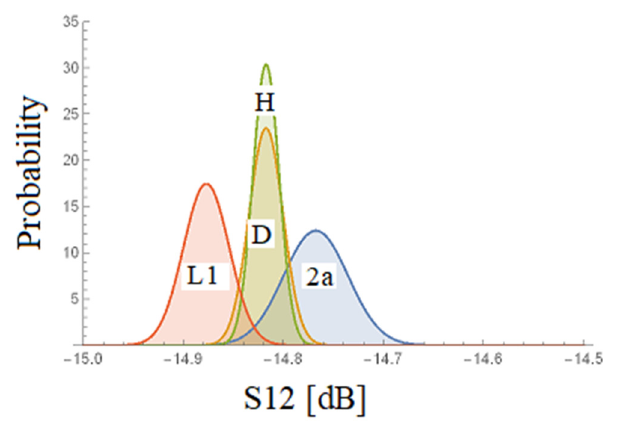
Figure 15. The S12 magnitude of diamonds in a bell-shaped graph at a frequency of 7.175 GHz.